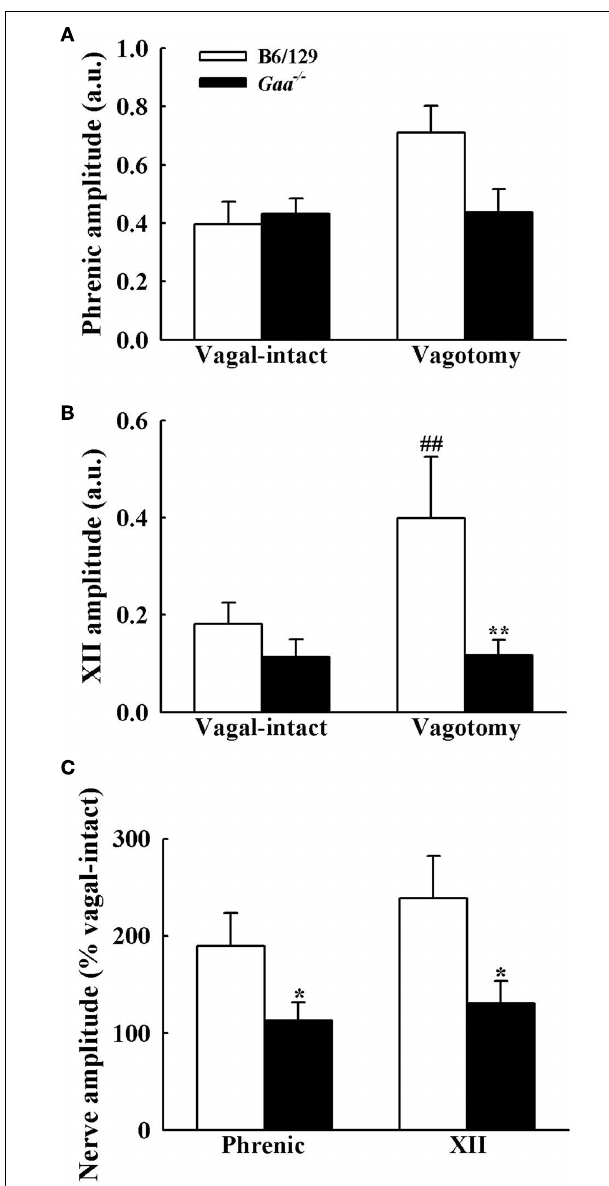
FIGURE 7 | Inspiratory phrenic and XII burst amplitude B6/129 and Gaa − / − mice. The amplitude of phrenic (A) and XII (B) neurogram inspiratory burst amplitudes were expressed as arbitrary units (a.u.), and normalized to the activity recorded under vagal-intact conditions (C) . Cervical vagotomy caused robust increases in XII burst amplitude in B6/129 but not Gaa − / − mice. See text for a commentary on the phrenic burst amplitude. * p < 0.05; ** p < 0.01 significant different from B6/129 mice. # p < 0.05; ## p < 0.01 compared with the value during vagal-intact condition.